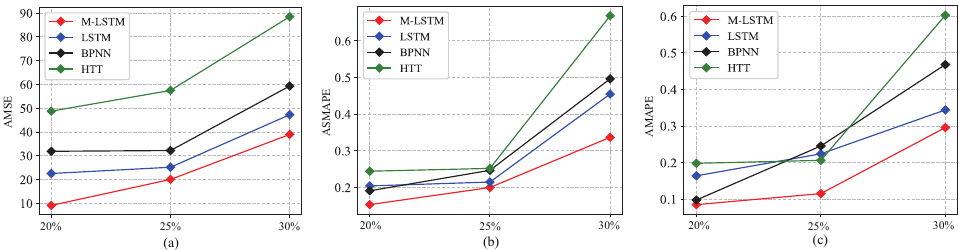
Figure 15. Results of: ( a ) AMSE of M–LSTM, LSTM, BPNN, and HST models under different predic- tion lengths, ( b ) ASMAPE of M–LSTM, LSTM, BPNN, and HST models under different prediction lengths, ( c ) AMAPE of M–LSTM, LSTM, BPNN, and HST models under different prediction